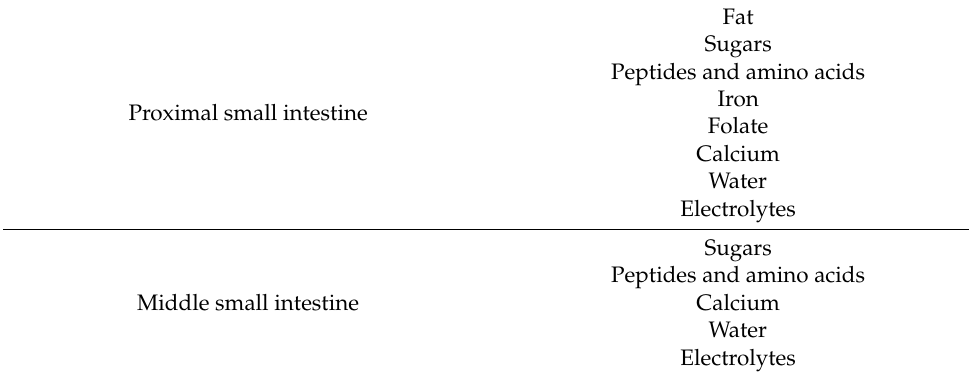
Table 6. Specific areas of absorption in the small intestine and